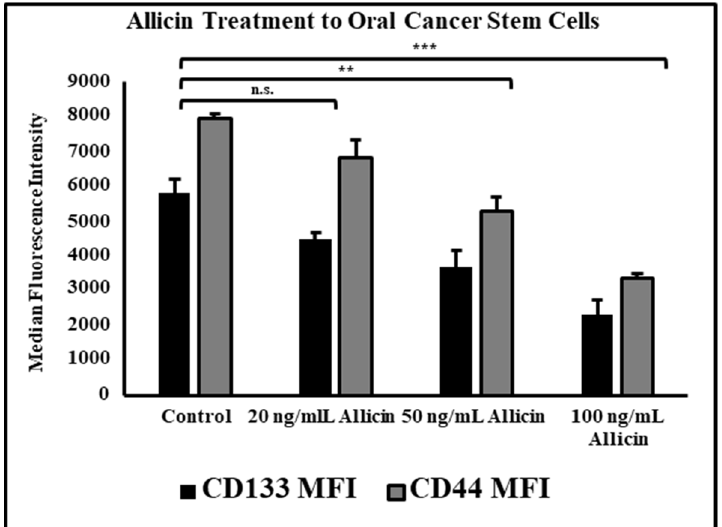
Figure 5. OSCC stem cells were treated with the different concentrations of allicin and acquired on flow cytometer to examine the expression of cancer stem cell markers CD133 and CD44. n.s. not significant, ** p < 0.05, *** p < 0.01 .